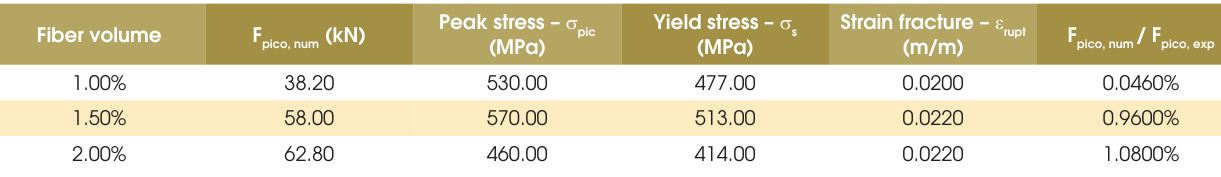
Table 5 – Model parameters of homogenization of La Borderie [4] for concrete with 1.0, 1.5, and 2.0%